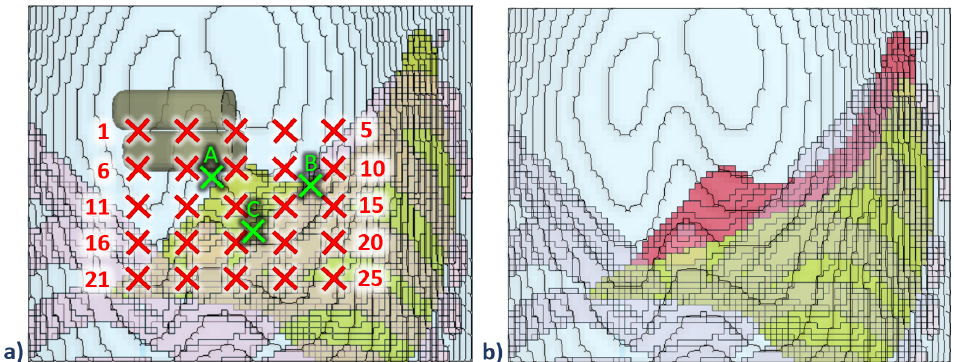
Figure 4. ( a ) Simulation sequence with fingers indentation up to 15 mm on locations across the liver region on top of the abdomen. The simulation started with the fingers at position 1 on the top-leftmost location, and ended with the fingers at position 25 on the bottom-rightmost location. The red crosses represent locations with FEM simulation data for ANN training, whereas the green crosses at locations A , B and C are taken as the data unseen by the ANN algorithm for testing. ( b ) The region of interest (ROI) on the surface edge of the liver tissue (depicted in red) with 377 elements for surrogate model training. The ribs are not shown as to not occlude the view of the